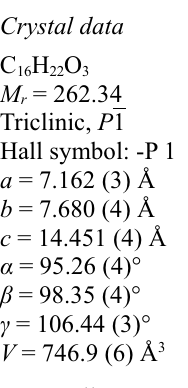
Figure 1 The molecular structure of the title compound. Displacement ellipsoids are drawn at the 50% probability level. trans -4-[(2,6-Dimethylphenoxy)methyl]cyclohexanecarboxylic